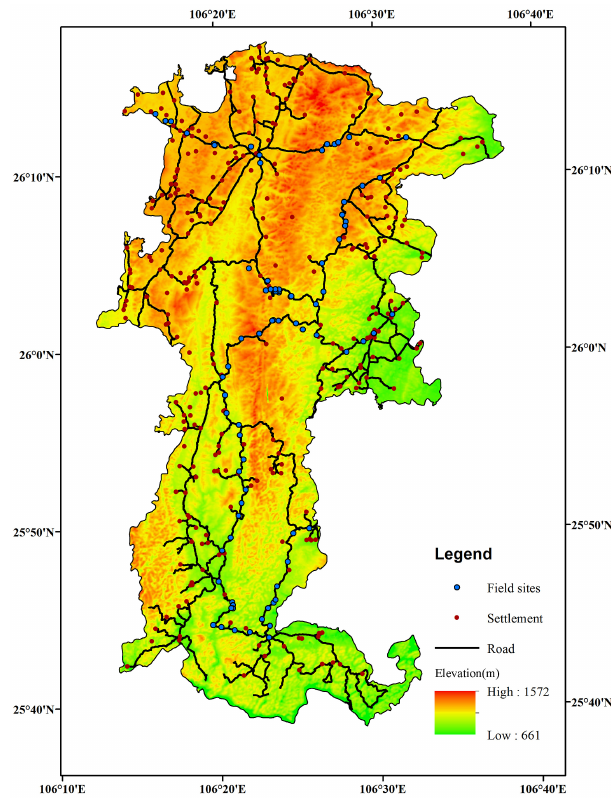
Figure 1. The location of Changshun County.